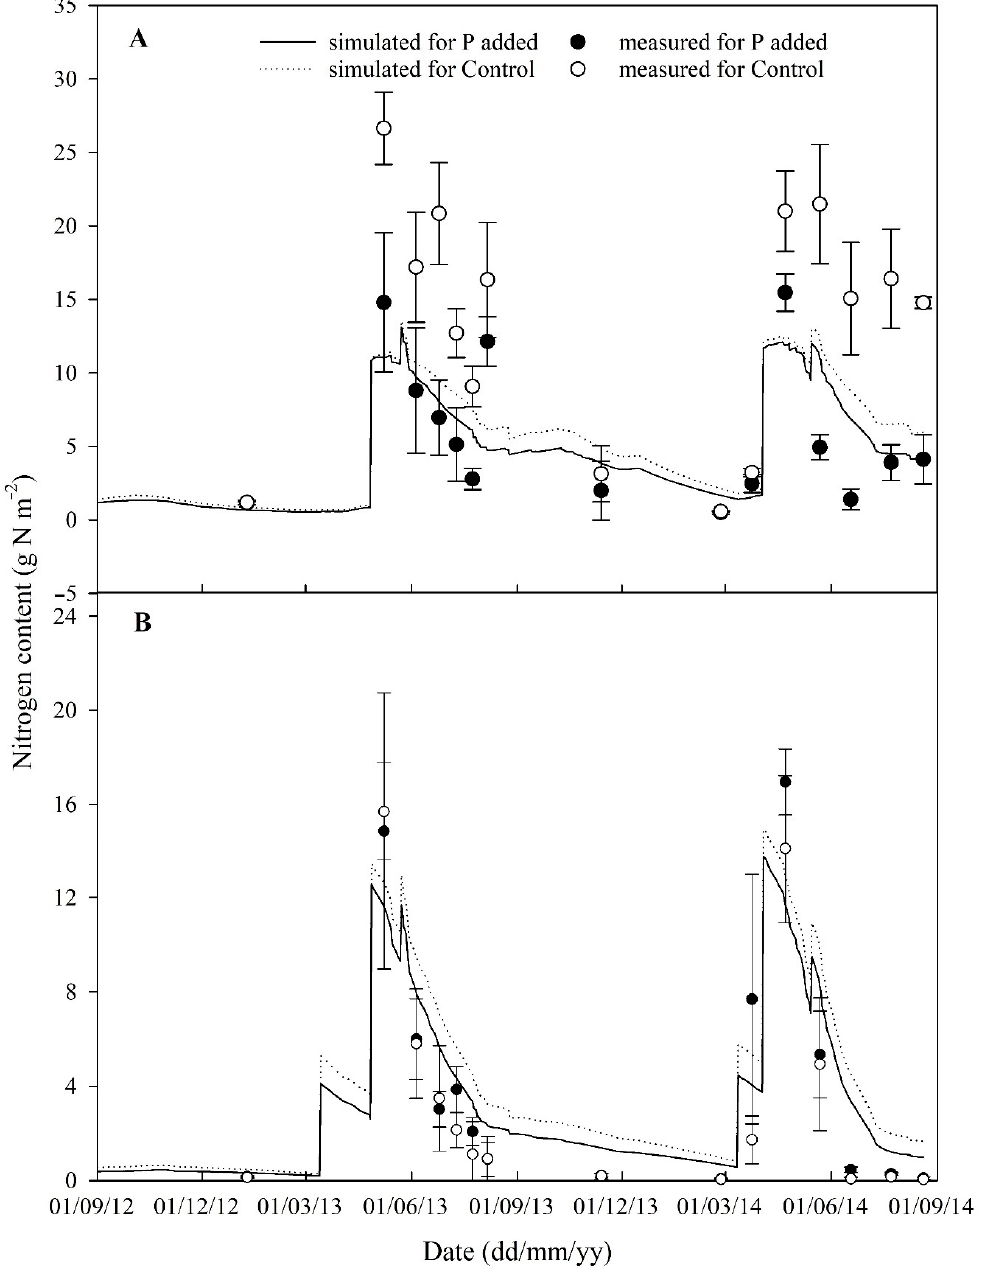
Figure 2. Comparison of nitrate ( A ) and ammonium ( B ) contents in the top soil (0–23 cm) between simulation and observation (three replications) over the two growing seasons for both Control and P added treatments. Error bars represent the standard deviation.